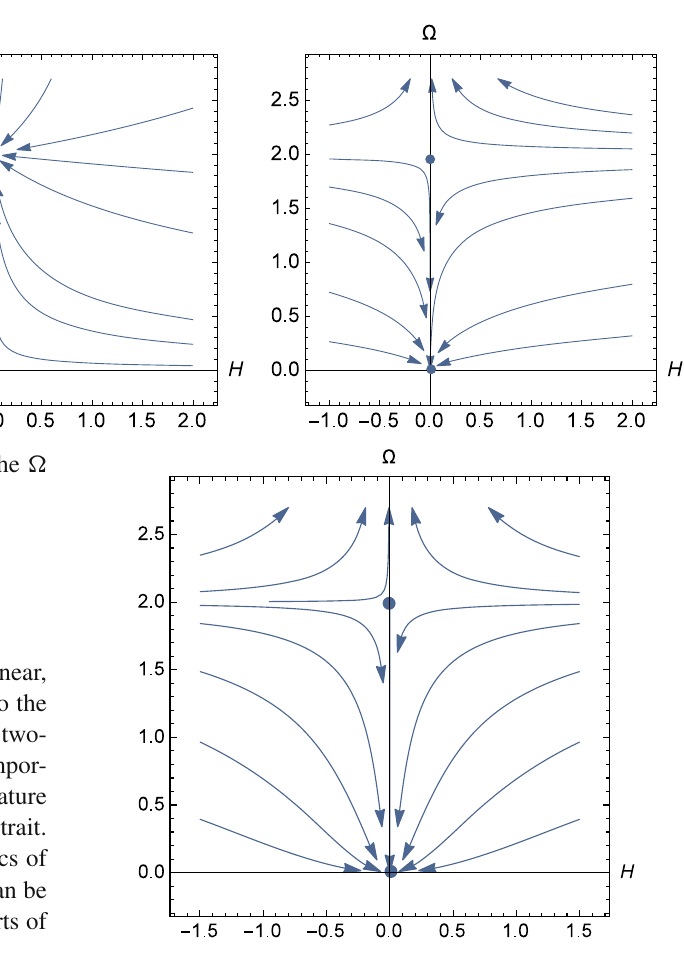
Fig. 6 Phase portrait of the system (2.25)–(2.26) for arbitrary λ and γ =